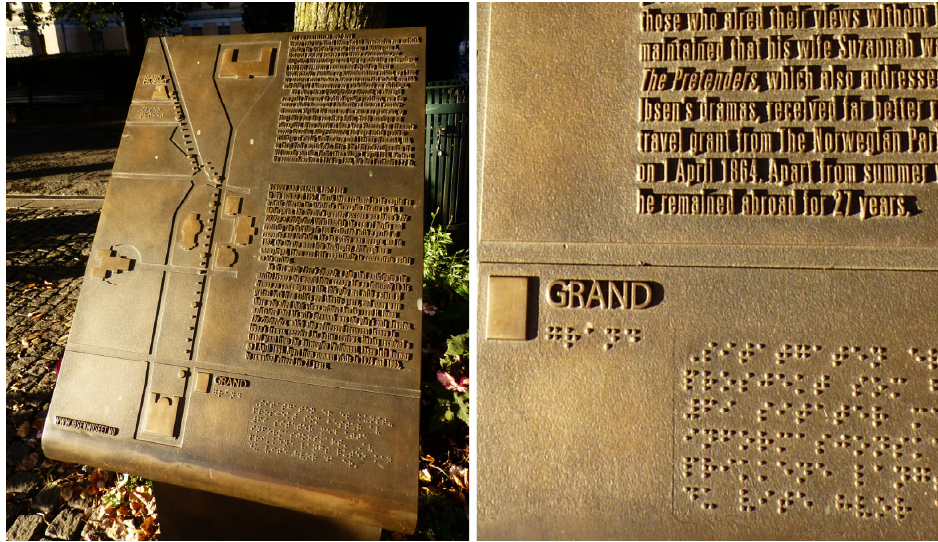
Figure 1. Information board containing a tactile map with a description in both Latin script and Braille (source: authors).